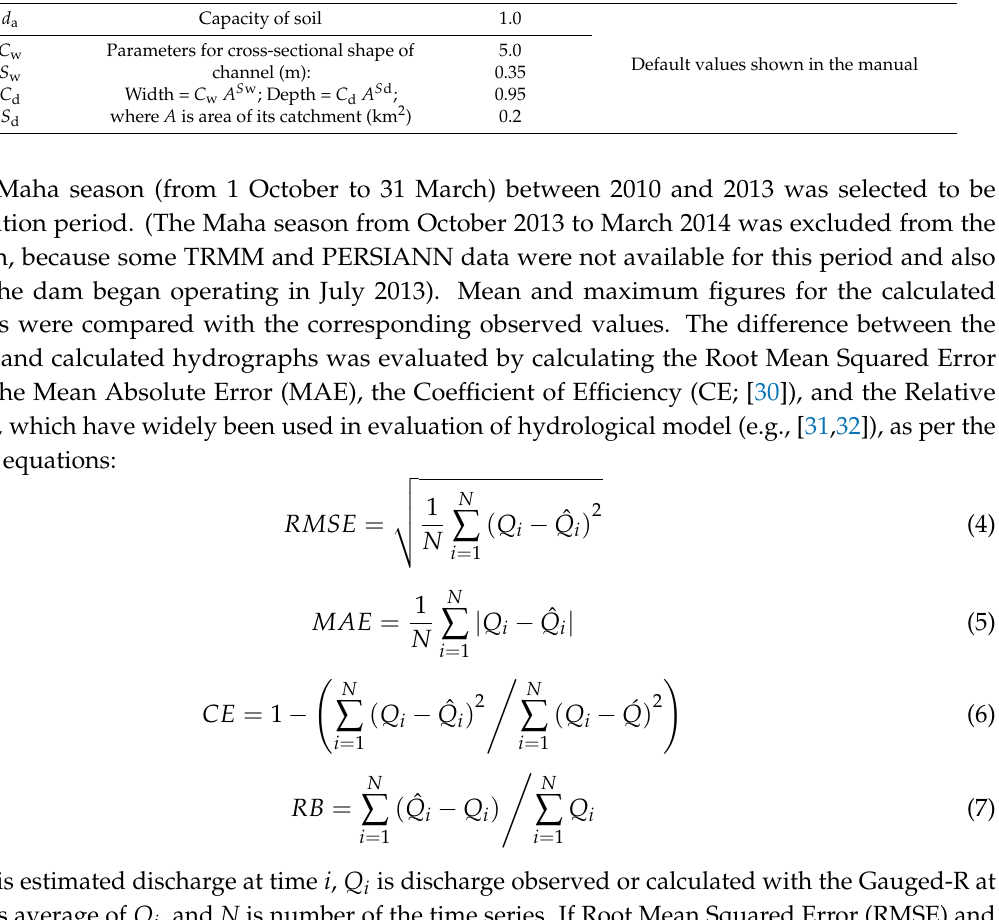
Determined by calibration n